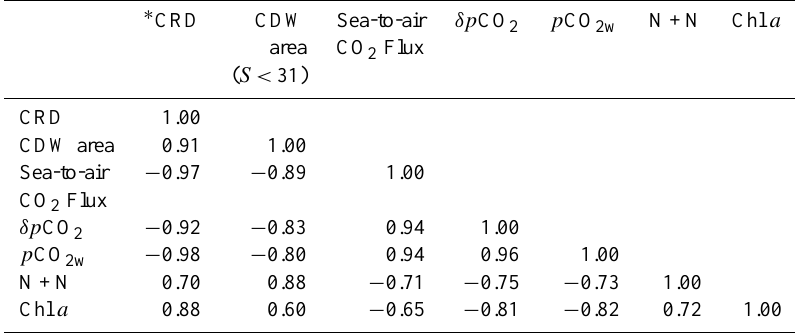
Table 1. Correlation coefficient matrix for areal means of p CO 2 and other environmental variables in the ECS shelf in summer months from 1998 to 2011 ( n = 10). ∗ CRD CDW Sea-to-air δp CO 2 p CO 2w N+N Chl a area CO 2 Flux ( S < 31) CRD 1.00 CDW area 0.91 1.00 Sea-to-air − 0.97 − 0.89 1.00 CO 2 Flux δp CO 2 − 0.92 − 0.83 0.94 1.00 p CO 2w − 0.98 − 0.80 0.94 0.96 1.00 N+N 0.70 0.88 − 0.71 − 0.75 − 0.73 1.00 Chl a 0.88 0.60 − 0.65 − 0.81 − 0.82 0.72